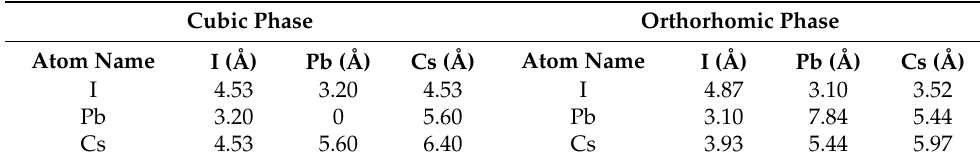
Table 3. Distance between the atoms inside the CsPbI 3 pure inorganic perovskite.